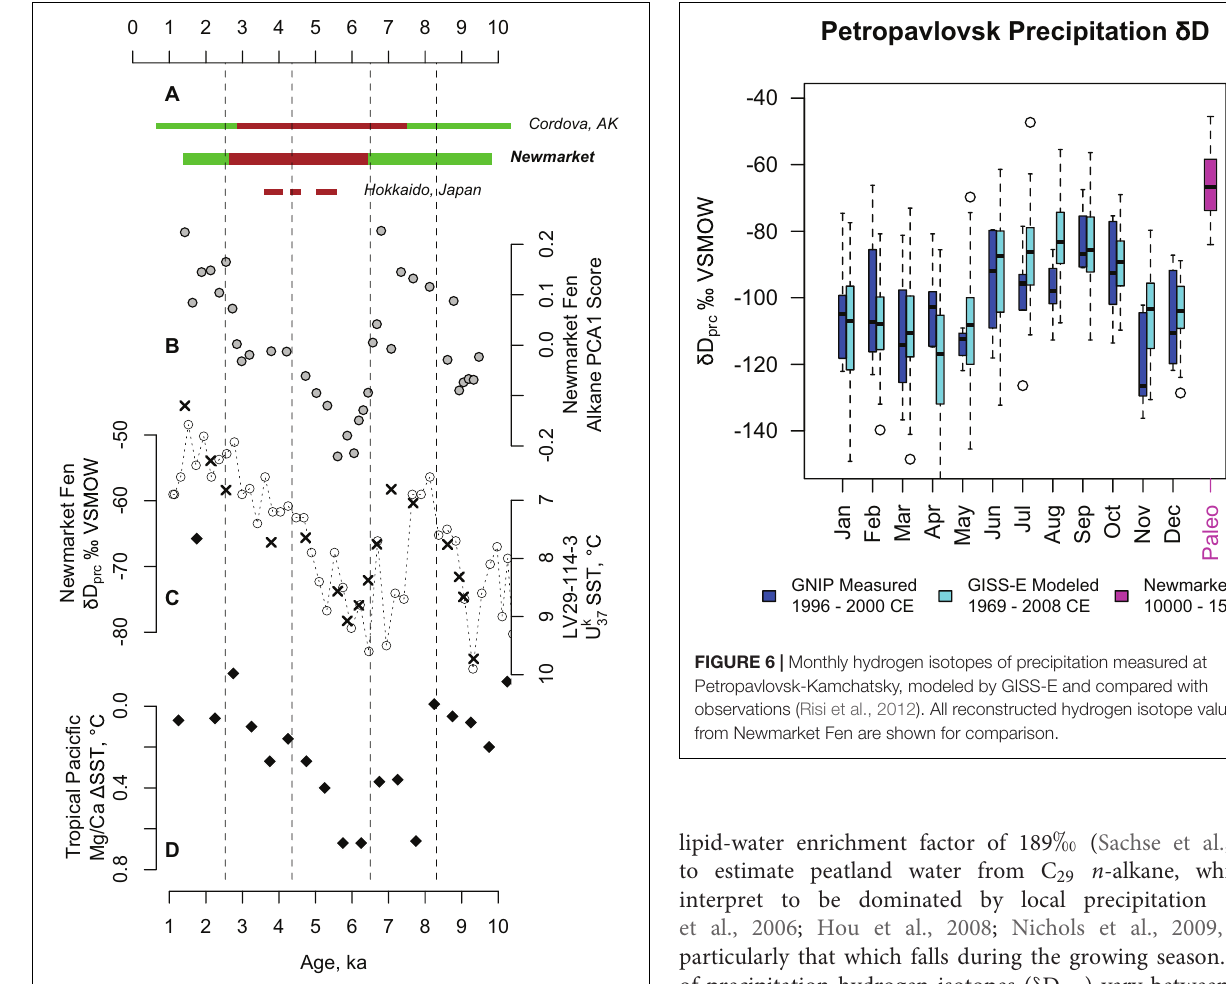
( Figure 5 ). We find depleted values of δ D prc within stratigraphic zones associated with dry, low carbon accumulation conditions in the middle Holocene and vice versa ( Figure 4 ). We also find that δ D prc corresponds closely with sea surface temperature (SST) in the southeastern Sea of Okhotsk (Max et al., 2012; Figure 5